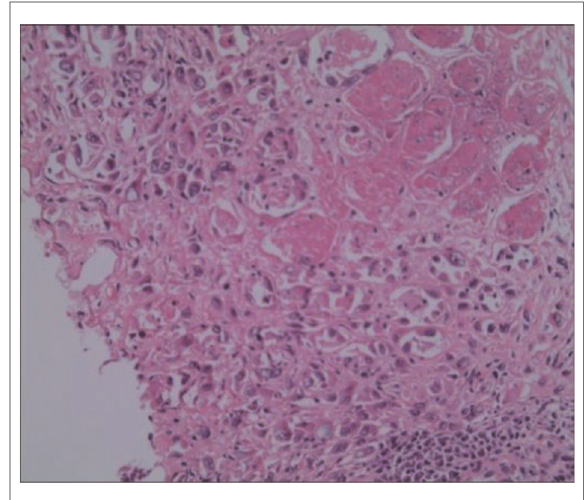
FIGURE 4 Pathological examination of the right thigh tumor showed metastatic poorly differentiated carcinoma and invasion of striated muscle (HE staining,